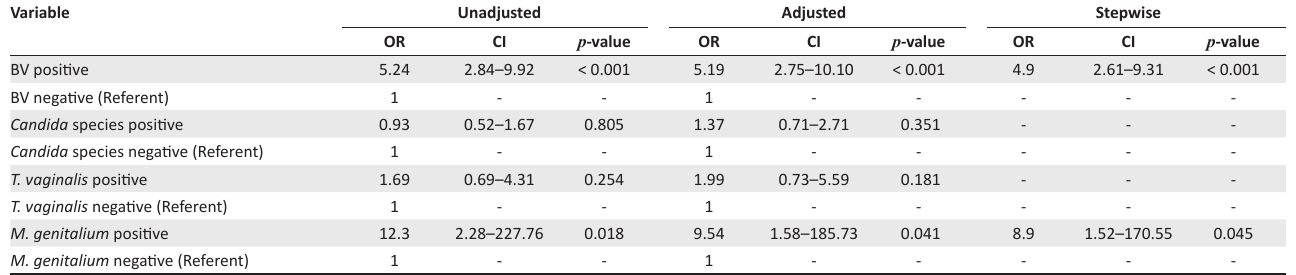
TABLE 4: Risk of acquiring Mycoplasma hominis in the presence of other genital infections. Variable Unadjusted